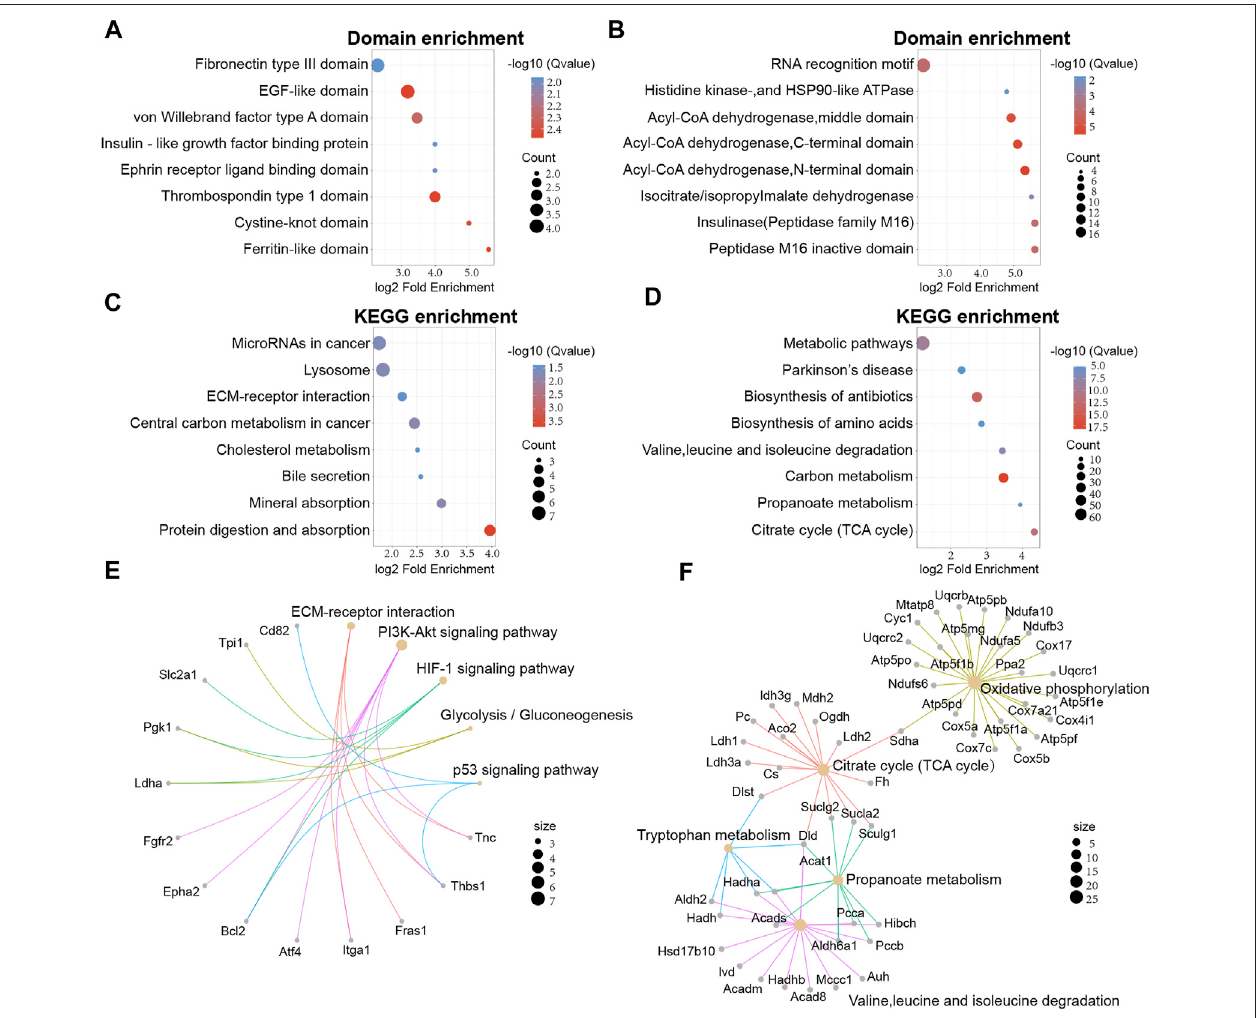
FIGURE 4 | Protein domain and KEGG enrichment analysis of differentially expressed proteins in global proteome and acetylated proteome. (A) Domain enrichment analysis of the global proteome. (B) Domain enrichment of the acetylated proteome. (C) KEGG pathway enrichment analysis for the global proteome. (D) KEGGpathwayenrichmentanalysisoftheacetylatedproteome. (E) Networkmapofspeci fi cKEGGpathwaysintheglobalproteome. (F) Networkmapofspeci fi cKEGG pathways in the acetylated proteome.